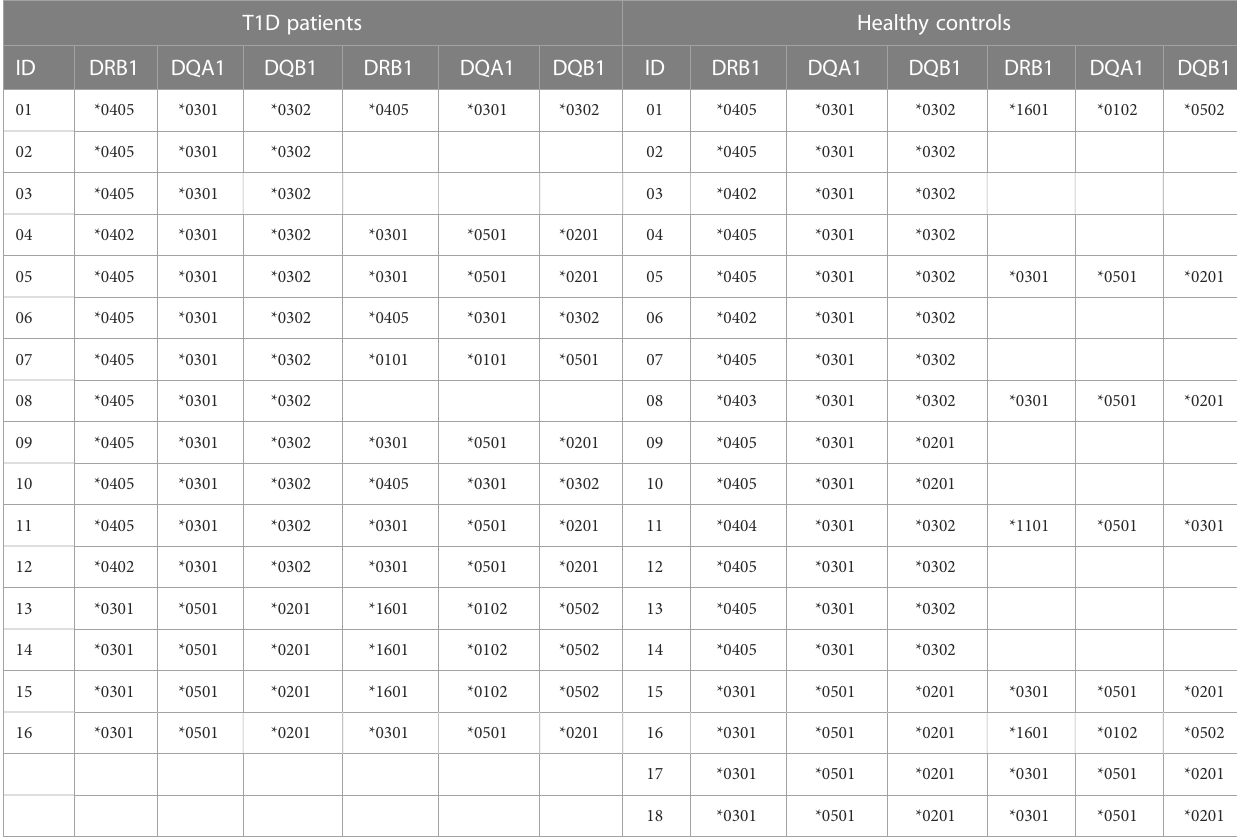
TABLE 1 HLA typing, in 16 recent-onset T1D patients and 18 ethnically matched